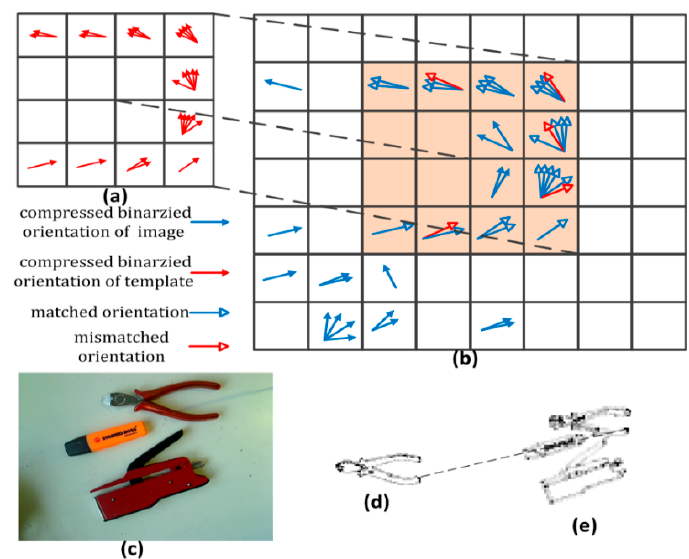
Figure 3. Illustration of the similarity measure. ( a ) Part of the quantized orientation compressing map of the template; ( b ) CMT as a sliding window is used to calculate the similarity measure for each location in the CMI; ( c ) The input image; ( d ) Orientation compressing map of the template (CMT); ( e ) Orientation compressing map of the input image (CMI).